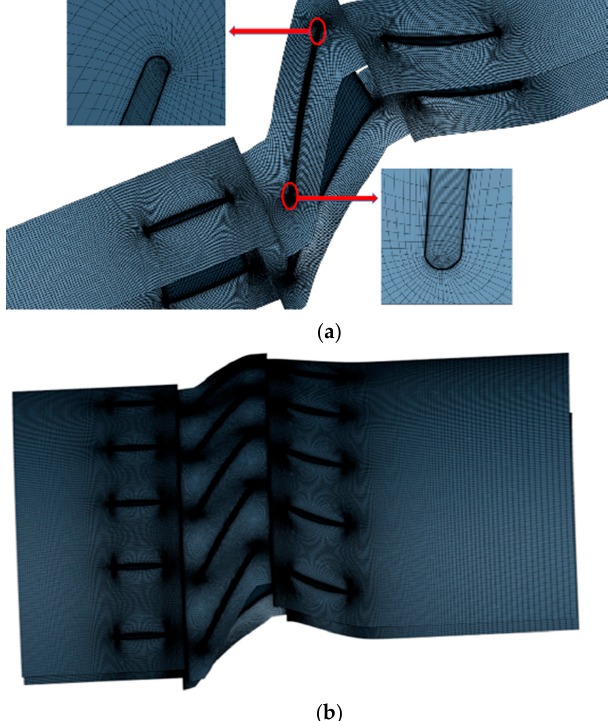
Figure 2. Mesh of computation domain: ( a ) single-passage model; ( b ) five-passage model.